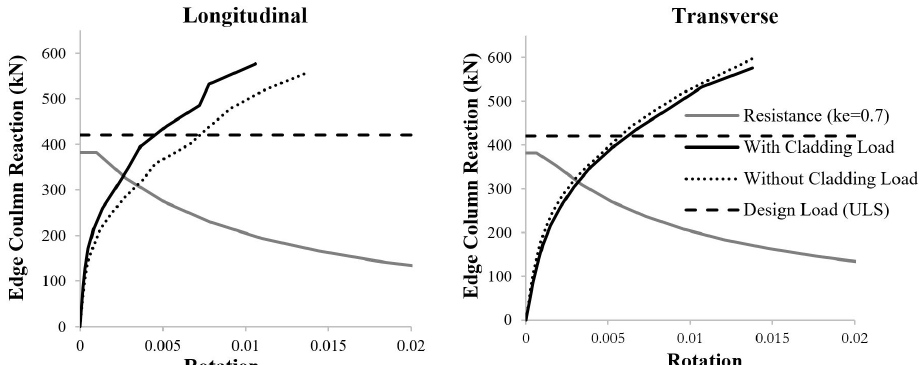
Figure 13. Comparison between longitudinal and transverse rotations with and without cladding loads for ρ sup = 0.8% and ρ span = 0.6%.